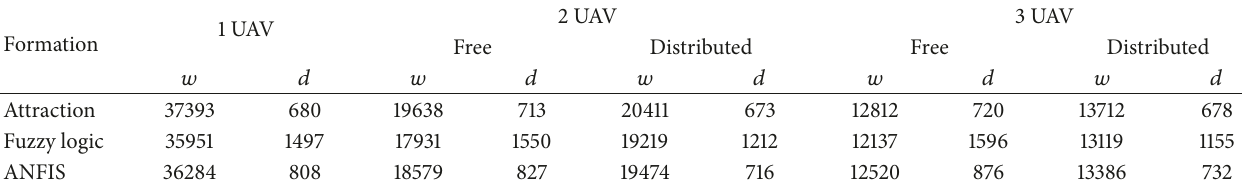
Table 7: Comparison between the different